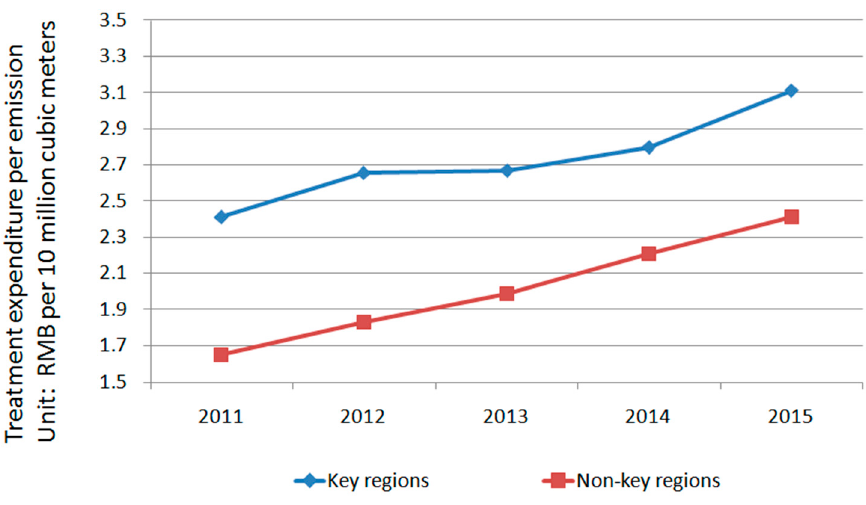
Figure 4. Comparing treatment intensity between key and non-key regions.